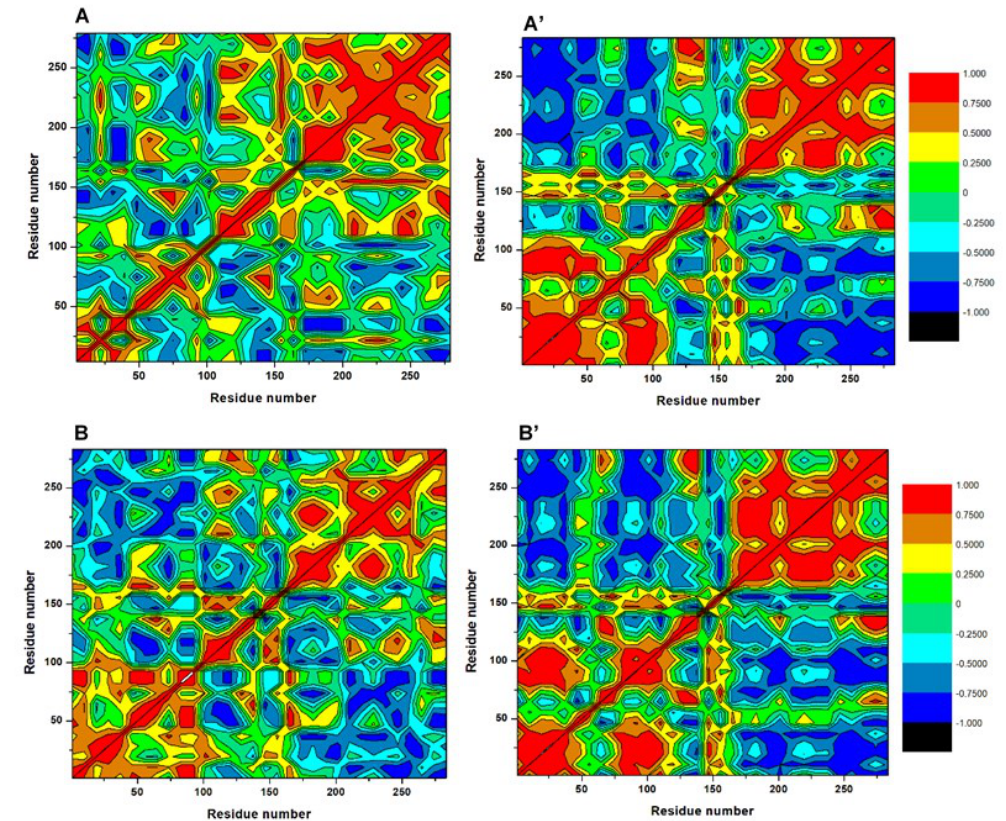
Figure 6. Dynamic cross-correlation matrices of the Ca fluctuations in the ultimate 30 ns simulation period ( A ) 33 -bound PknA, ( A’ ) 57 -bound PknA ( B ) 33 -bound PknB and ( B’ ) 57 -bound PknB.